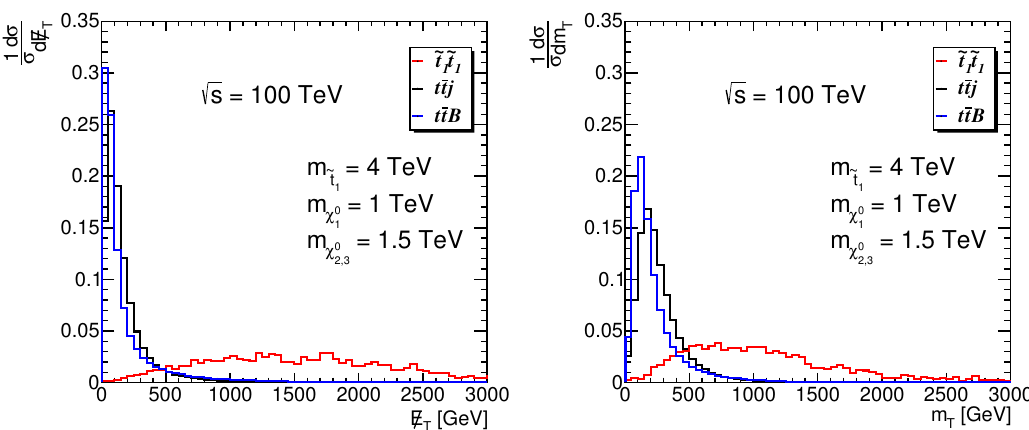
E (left) and m T (right) for the signal channel t (cid:22) thZ T 6 = 1000 GeV as well as SM backgrounds after the N j , N ‘ and (cid:31) 0 1